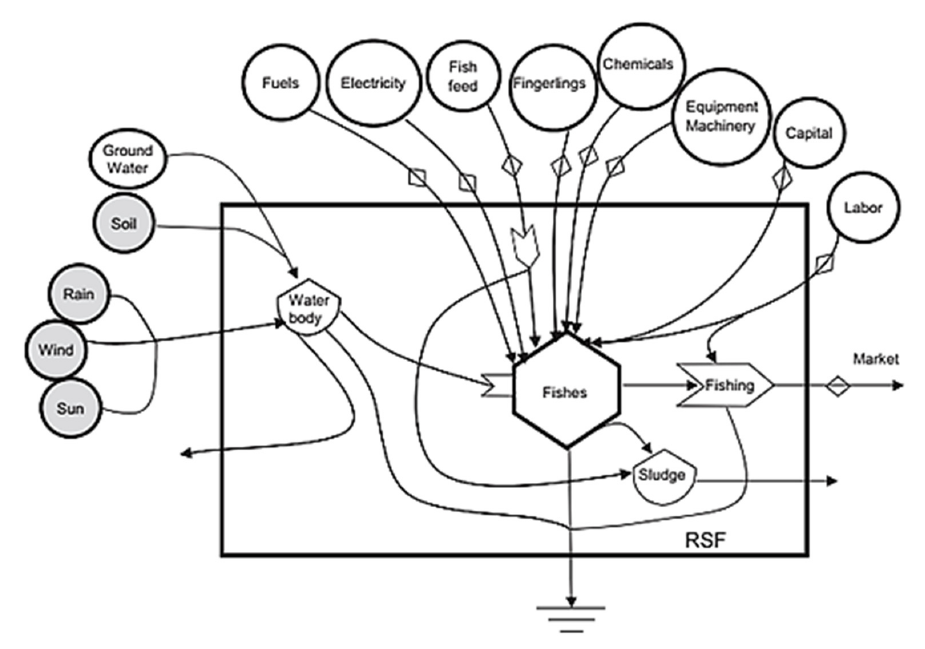
Figure 2. Example of an energy system diagram of fish production in a recirculation system. Source: Wilfart et al. (2013).